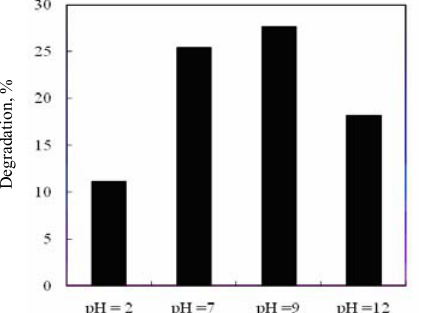
: 40 mg; V=20 mL; 2